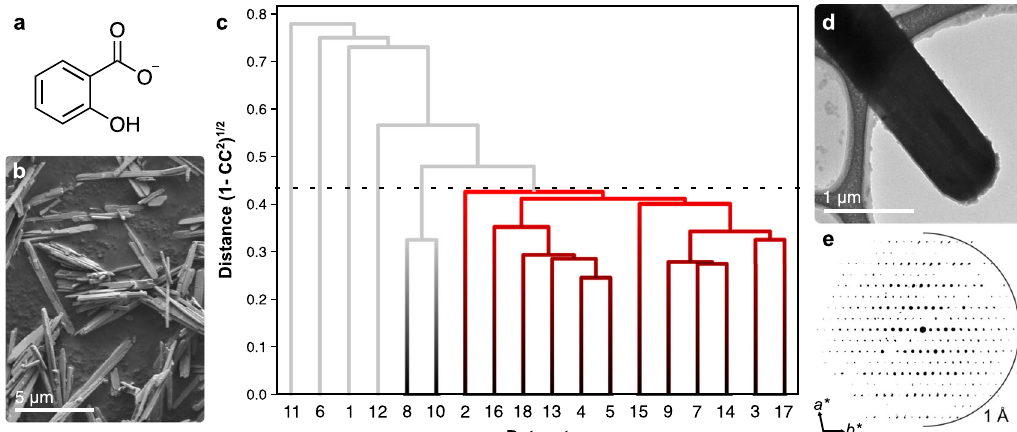
Fig. 1 Three-dimensional electron diffraction studies on BSS. a Molecular structure of the salicylate anion (Hsal − ). b Scanning electron micrograph of bismuth subsalicylate from Sigma-Aldrich (BSS-SA). c A dendrogram for the hierarchical clustering of the 18 individual 3DED data sets with the correlation coef fi cient cut-off shown as a dashed line. The red branch represents 12 highly correlated data sets with a distance below 0.44, which were merged into a single combined 3DED data set. d TEM image of one of 18 BSS-SA crystals used for the collection of 3DED data. e The reconstructed reciprocal space projection of a single 3DED data set viewed along c * (half-circle is drawn at a resolution of 1